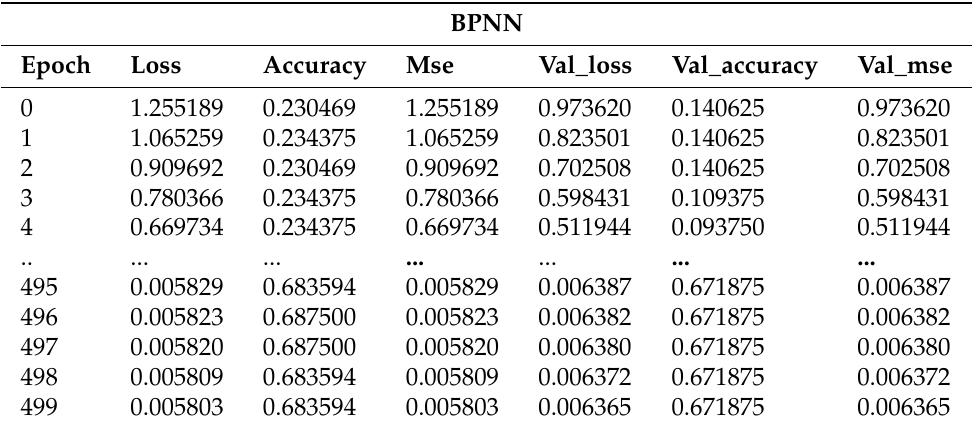
Table 14. BPNN accuracy curve.